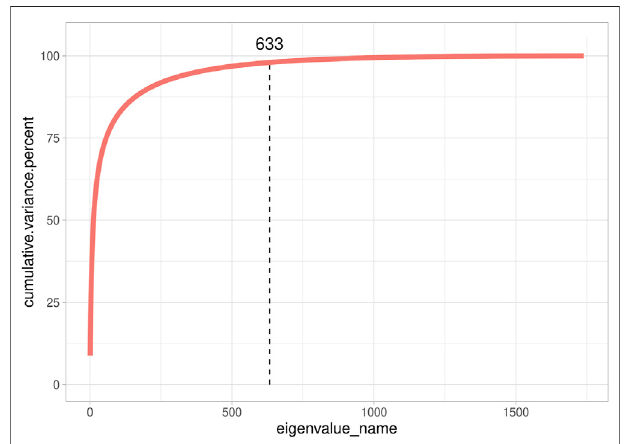
FIGURE 3 | Cumulative explained variance of all eigenvalues of the genomic relationship matrix of Rendena populations.